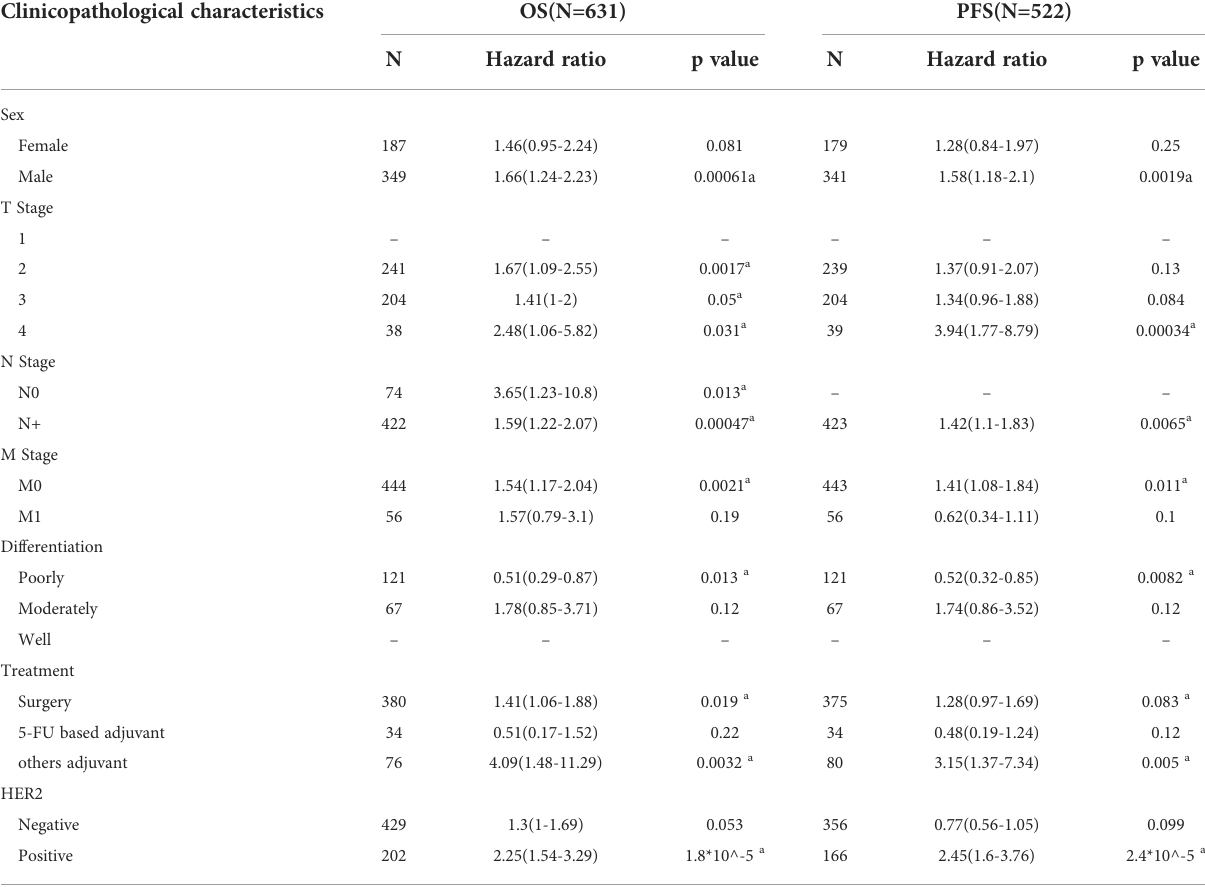
TABLE 1 Correlation of SLFN5 mRNA expression and clinical prognosis in GC with different clinicopathological factors by Kaplan-Meier plotter. Clinicopathological